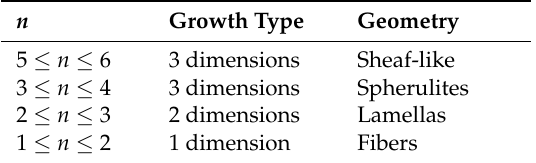
Table 4. Values of “ n ” for different growth type and geometry of crystals